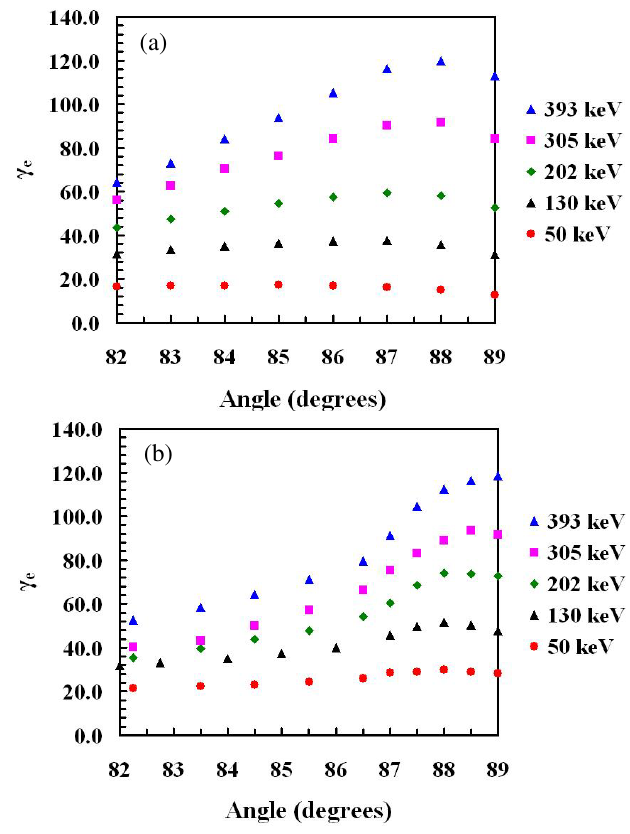
FIG. 4. (Color) Ion-induced electron emission yields. for K (cid:1) ions with different energies hitting (a) Theoretical (cid:3) e stainless steel target obtained from Eq. (10). (b) Experimental (cid:3) for K (cid:1) ions with different energies hitting stainless steel target obtained using GESD at